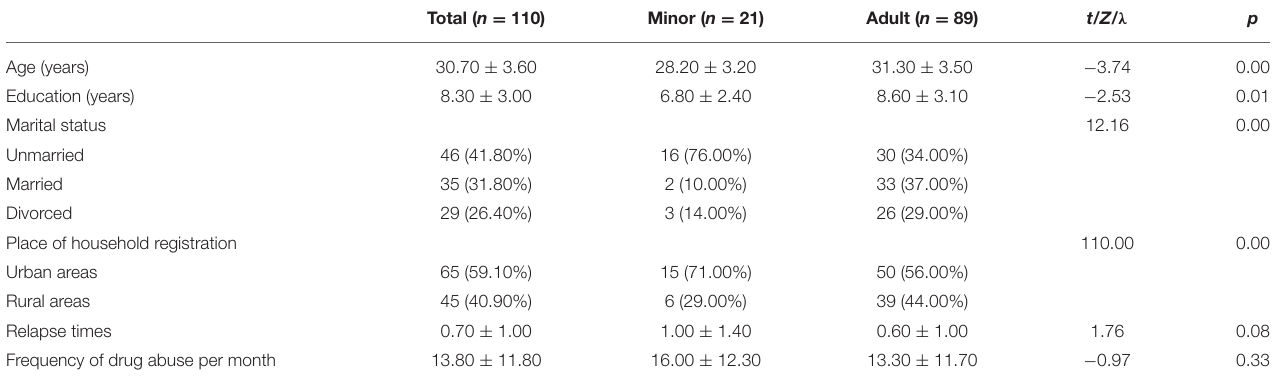
TABLE 1 | Social demographic characteristics of methamphetamine dependent patients.